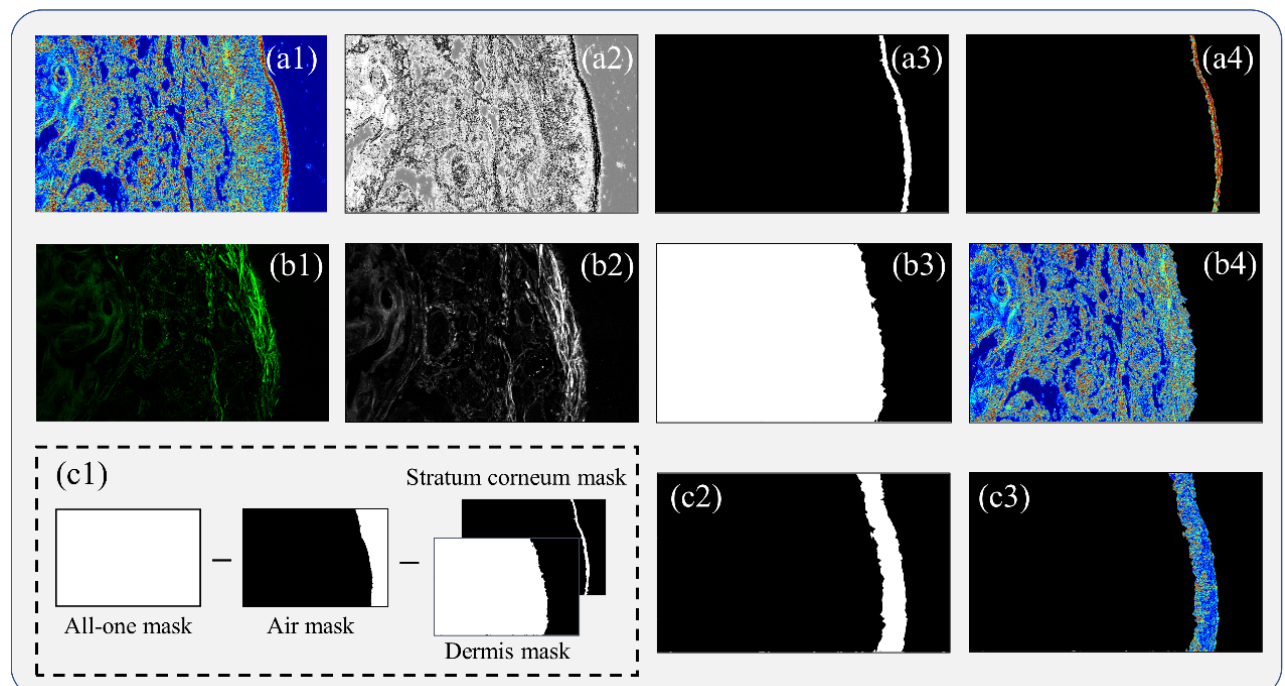
Figure 2. Skin layer segmentation process based on dual-modality Mueller matrix and SHG imag- ing: ( a1 – a4 ) stratum corneum layer segmentation process: ( a1 ) MMPD- δ image, ( a2 ) gray-scale image converted from the MMPD- δ image, ( a3 ) stratum corneum mask, ( a4 ) segmented stratum corneum layer; ( b1 – b4 ) dermis layer segmentation process: ( b1 ) SHG image, ( b2 ) gray-scale image converted from the SHG image, ( b3 ) dermis mask, ( b4 ) segmented dermis layer; ( c1 – c3 ) epidermis layer segmentation process: ( c1 ) all-one mask, air mask, stratum corneum mask, and dermis mask, ( c2 ) epidermis mask, ( c3 ) segmented epidermis layer.